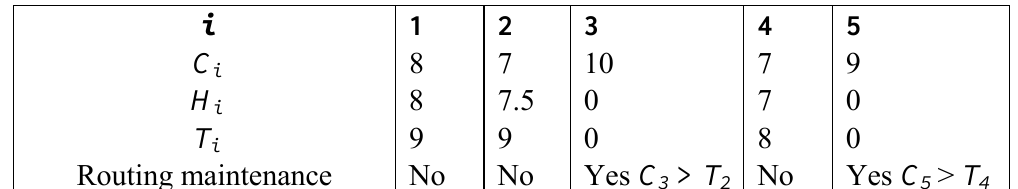
Table 2. Example of estimator.